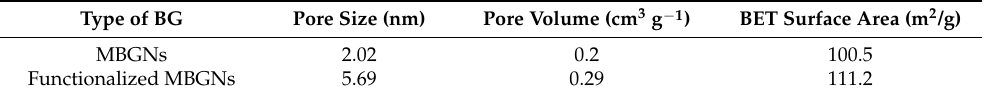
Figure 5. Nitrogen-adsorption/desorption isotherms of prepared MBGNs ( a ), pore-size distribution ( b ), nitrogen-adsorption/desorption isotherms of prepared functionalized MBGNs ( c ) and pore-size distribution ( d ). Table 2. Textural properties of the MBGNs developed according to the results of the BET analysis.